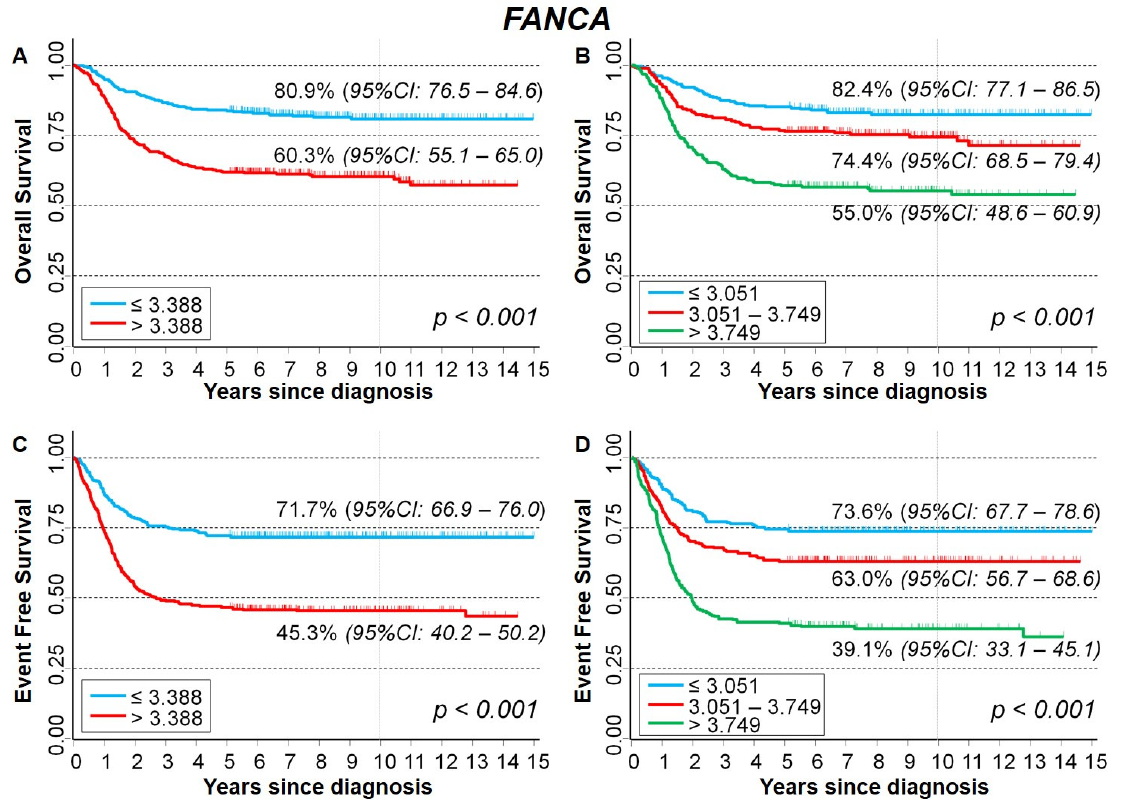
Figure 9. Kaplan–Meier survival curves of the whole cohort of 786 NB patients in relation to FANCA gene-expression values. ( A ) Overall survival, cut-off based on the median expression value; ( B ) Overall survival, cut-offs based on tertile expression values. ( C ) Event-free survival, cut-off based on the median expression value; ( D ) Event free survival, cut-offs based on tertile expression values. Ten-year survival estimates are displayed. Table 4. Survival of the whole cohort of patients with NB in relation to FANCA gene-expression values, evaluated by the multivariable Cox regression model.